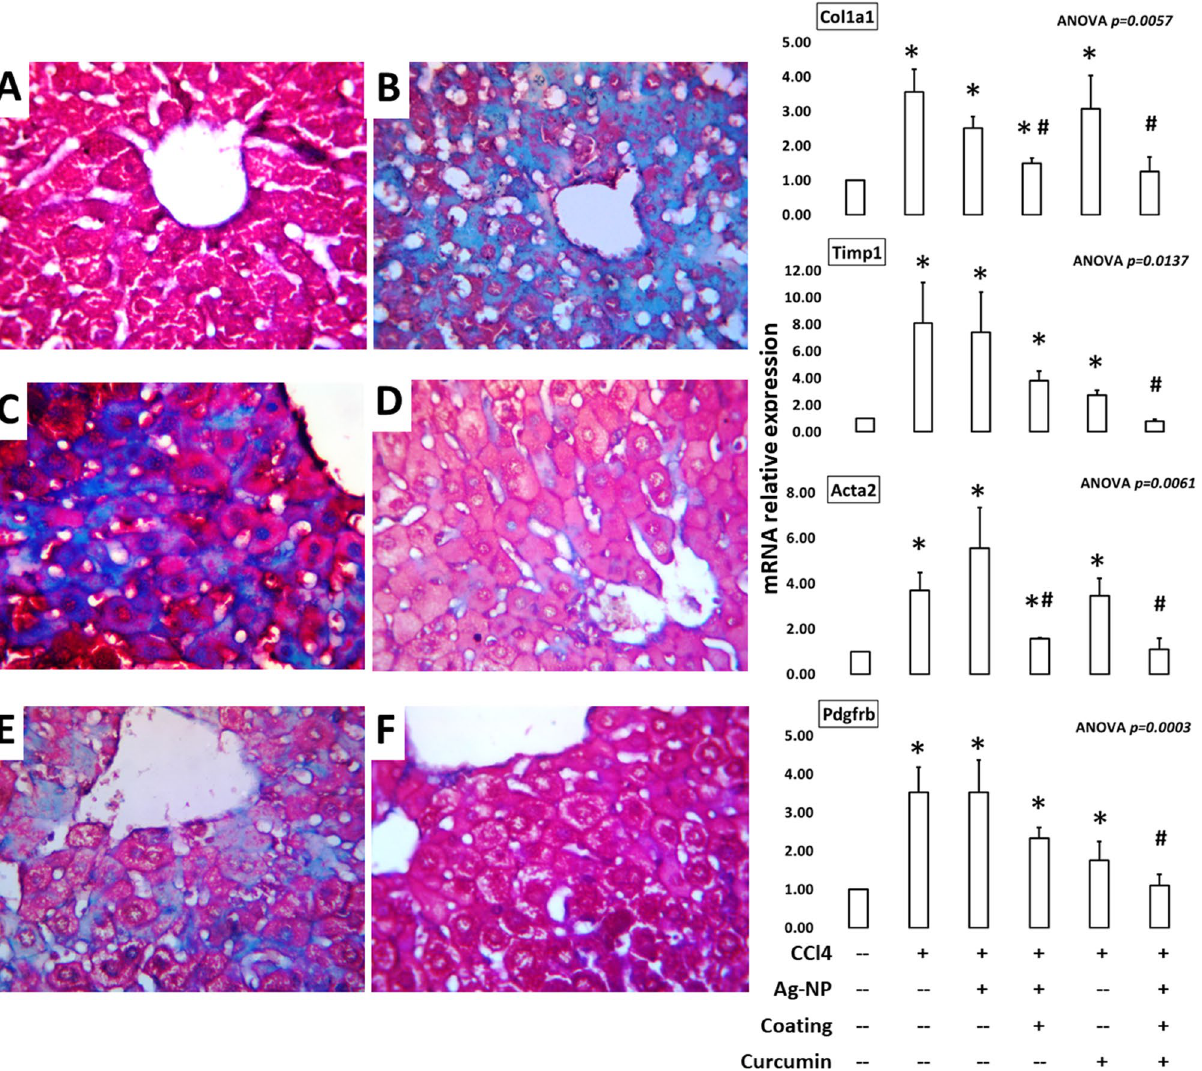
Figure 3. Treatment with the green synthesized curcumin/chitosan-coated silver nanoparticles prevents the development of fibrosis in CCl 4 -mice liver. Mice were concurrently treated twice a week with CCl 4 and once a week with different nano treatments or curcumin for 5 weeks. Left panel: Mason’s trichrome showing hepatic fibrosis (blue-stained) after induction by CCl 4 ( B – F ) and treatment with AgNPs ( C ), chitosan-coated AgNPs ( D ), curcumin ( E ), or curcumin/chitosan-coated AgNPs ( F ). ( A ) represents the negative control group. Right panel: Quantitative PCR analysis for genes involved in fibrogenesis of hepatic cells. RNA was extracted from mice livers after different treatments and transcribed to cDNA. RT-PCR was applied using these cDNAs and the primer pairs listed in Table 1. The shown data are averages of three separate experiments. Statistical analysis: ANOVA P < 0.05 for all genes; * denotes significantly different value from the control one; # denotes significantly different from value of CCl4-fibrosis group (posthoc t-test after